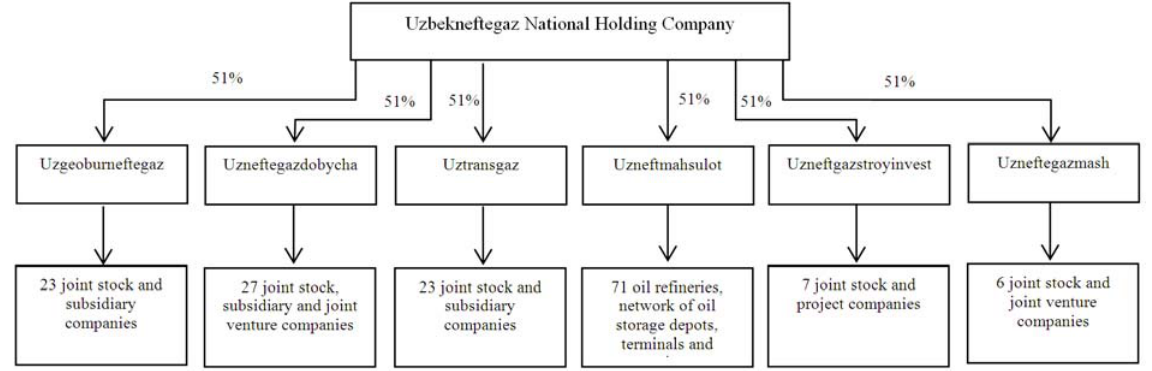
Fig. 4. The structure of Uzbekneftegaz National Holding Company Source: Uzbekneftegaz,